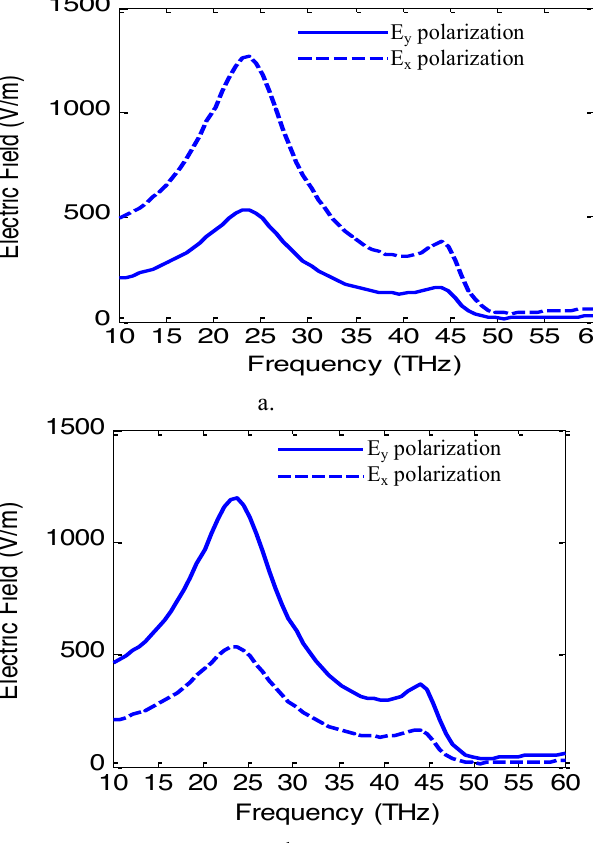
Fig ure 13a. The electric field variation versus frequency for rhombic dipole IR - nanoantenna on a dielectric substrate with h=150 nm, w=9 µ m, L=9 µ m, t=50 nm, gap=10 nm, L =2.2 µ m for (1, 3) , b. The electric field variation versus frequency for rhombic dipole IR - nanoantenna on a dielectric substrate with h=150 nm, w=5 µ m, t=50 nm, gap=10 nm, L =2.2 µ m for (2,